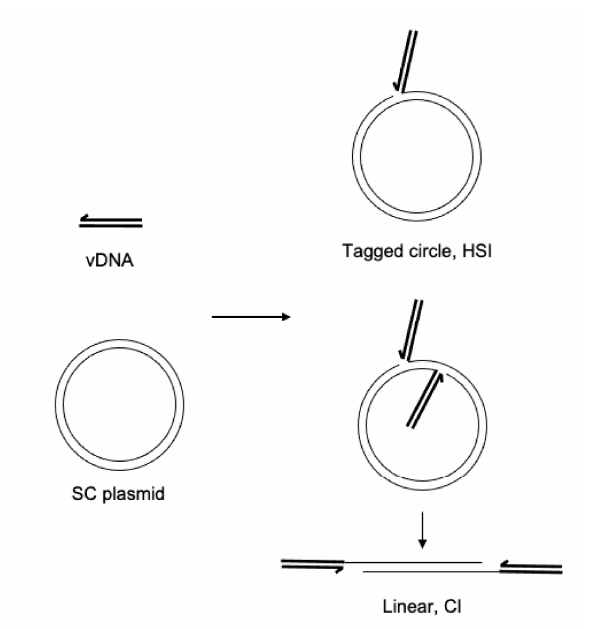
Figure 1. Integration assay reaction products. DNA oligomers mimicking the viral cDNA ends (vDNA, heavy black lines) are assembled with PFV IN to form intasomes. The intasomes are added to a supercoiled plasmid (SC plasmid, light black lines) and incubated at 37 ◦ C. The major products of integration are concerted integration (CI) where the two vDNAs of the intasome are covalently joined to the target SC plasmid. This results in a linear product with the vDNAs at each end. Additional CI to the linear product will result in shorter fragments. A minor product of intasome integration is half site integration (HSI), where only one vDNA is joined to the target DNA resulting in a tagged circle.